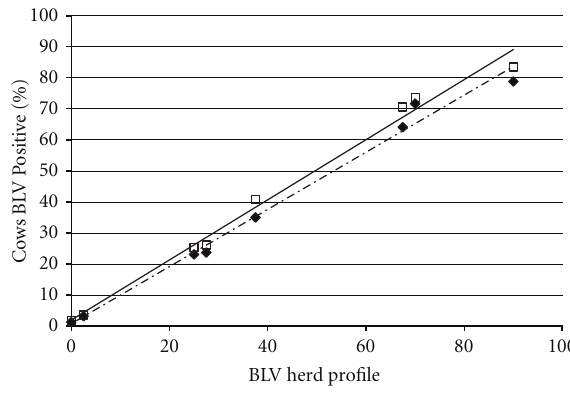
Figure 3: Bovine Leukemia Virus herd profile (BHP) by testing 40 milking cows (ten from each of the first, second, third and fourth or greater lactations), for Bovine Leukemia Virus (BLV) as compared to testing all milking cows in the herd and calculating either: (1) the actual BLV prevalence (solid line- (cid:2) ) as measured by the number of BLV positive cows divided by the total number tested, or (2) a lactation-specific BLV profile (dashed line- (cid:3) ), calculated as an average of the percent of BLV infected cows in each of the four lactation groups. The correlation between the actual BLV prevalence and BHP was 0.988 ( P = 0 . 0016), and the total herd profile and BHP was 0.995 ( P = 0 .